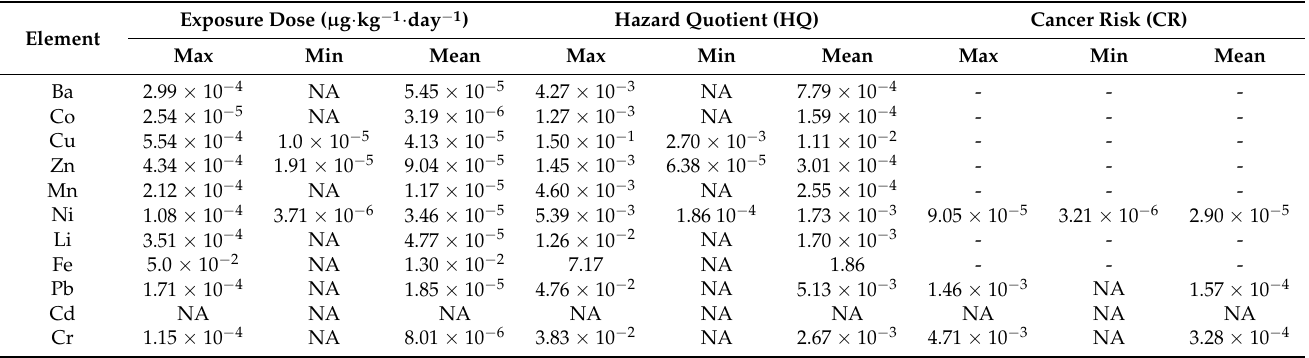
Table 3. Risk assessment of potentially toxic elements levels in drinking water